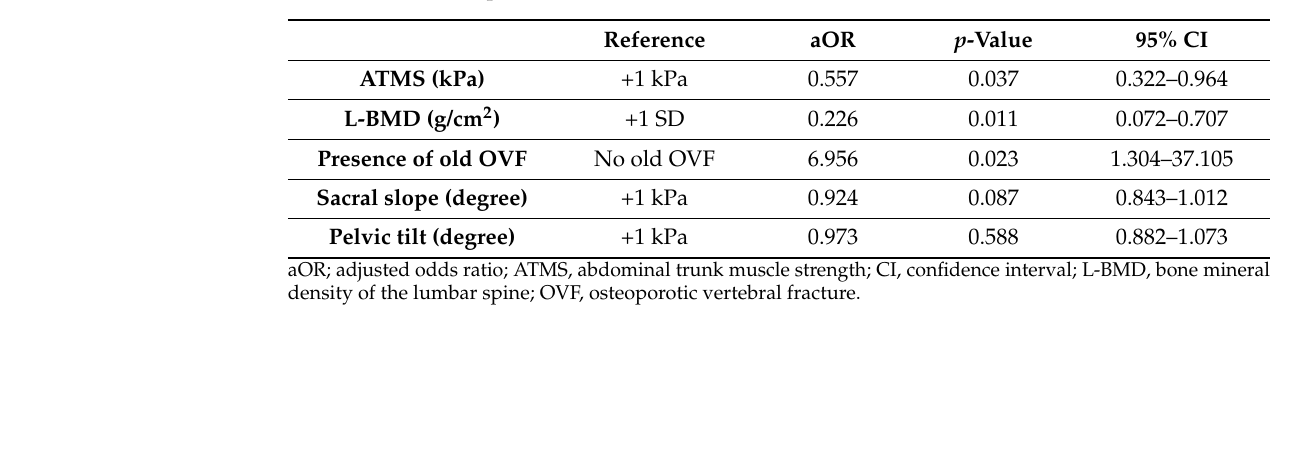
Table 3. Multivariate analysis of factors associated with the occurrence of new OVFs in the lower thoracic or lumbar